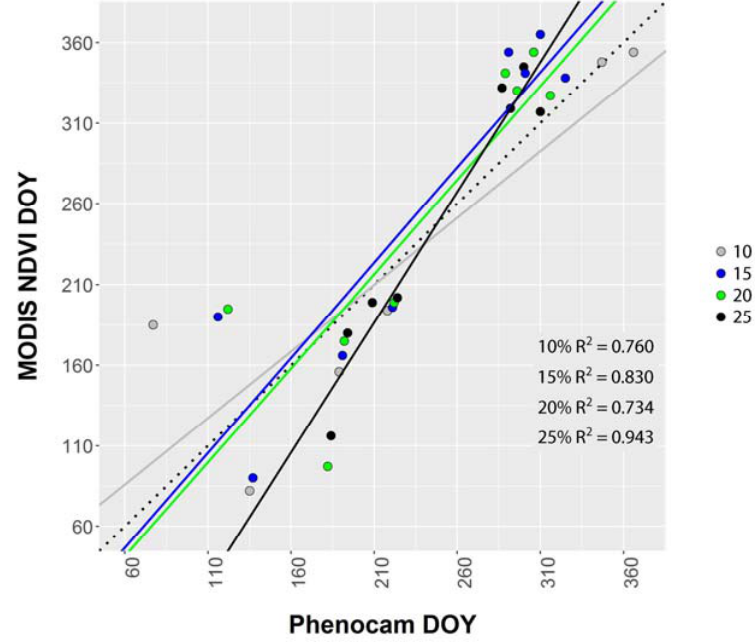
Figure 6. Linear regressions for SOS and EOS seasonal metrics from phenocam GCC for the landscape ROI with MODIS NDVI. SOS and EOS metrics derived from Timesat with four seasonal amplitude thresholds.